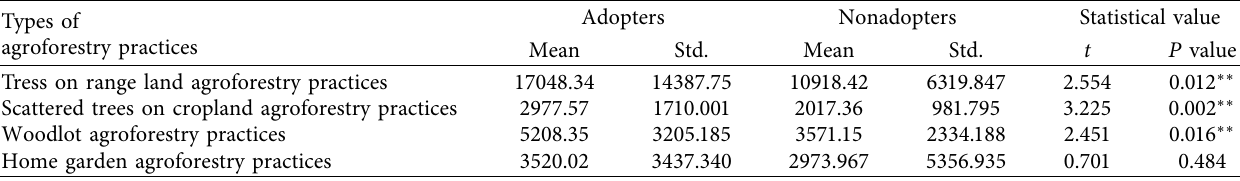
Table 5: Adopters and nonadopters mean annual household farm income (ETB) from agroforestry practices.